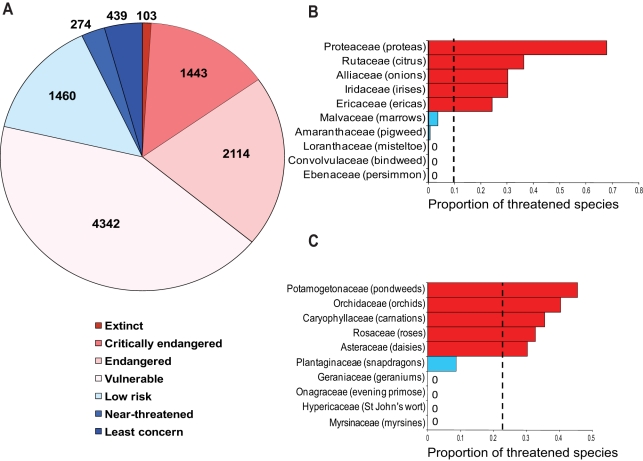
Taxonomic distribution of threat.Global number of angiosperm species listed within each category of the IUCN
Red List (A). Comparison of the taxonomic distribution of extinction risk
between the South African (B) and the British (C) floras (Tables
S3–S10). Families with higher than expected
proportions of threatened species are shown in red, and families with
significantly lower proportions of threatened species are shown in blue
(five most extreme families shown). The dashed line represents the mean
proportion of threatened species across all families.